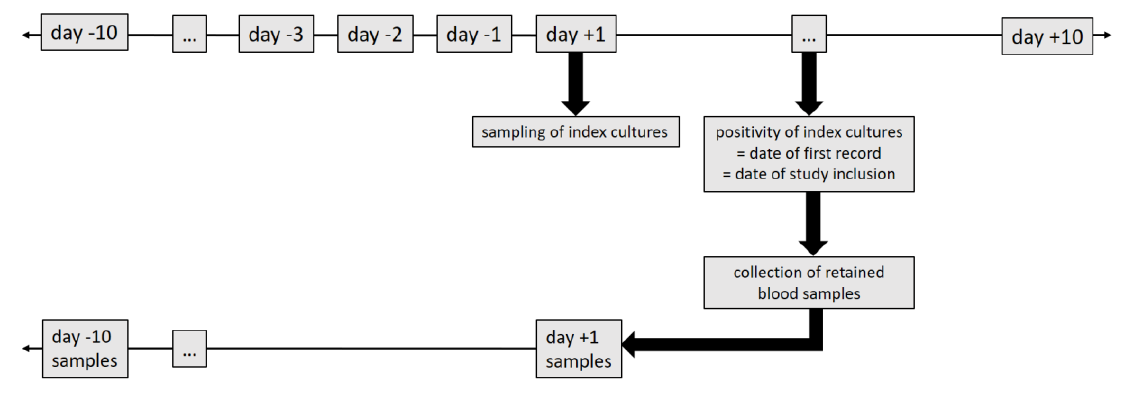
Figure A1. Sampling schedule.